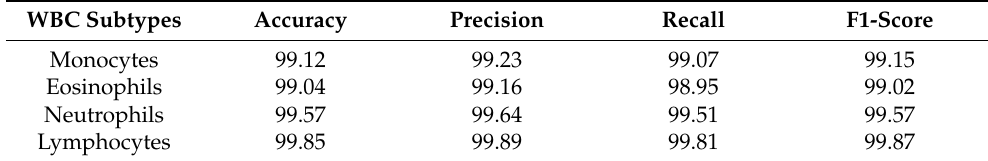
Table 3. Quantitative results of multi-class classification on BCCD dataset.